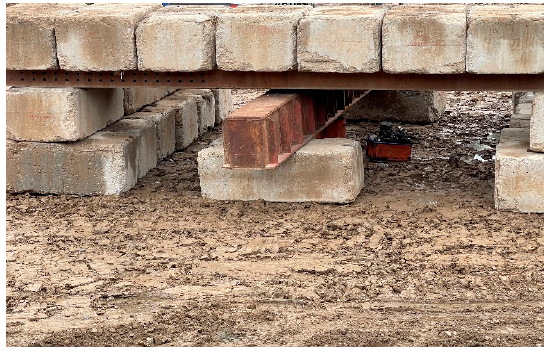
Figure 2. The field static load test drawing .